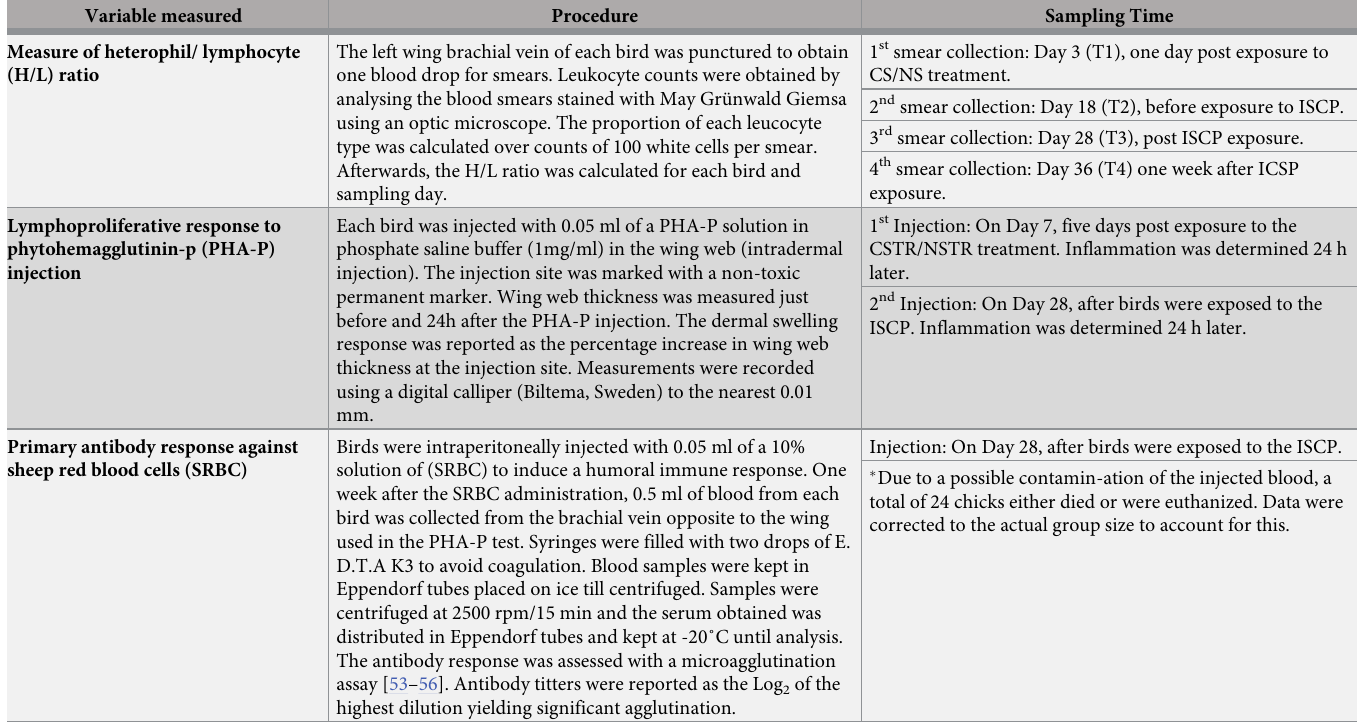
Table 2. Immune variables measured and time schedule for each test performed. T1, T2, T3 and T4 are times 1–4 respectively; CSTR/NSTR are the Cold Stress and No Stress treatments; ISCP refers the Intermittent Stressful Challenges Protocol. Variable measured Procedure Sampling Time Measure of heterophil/ lymphocyte (H/L) ratio